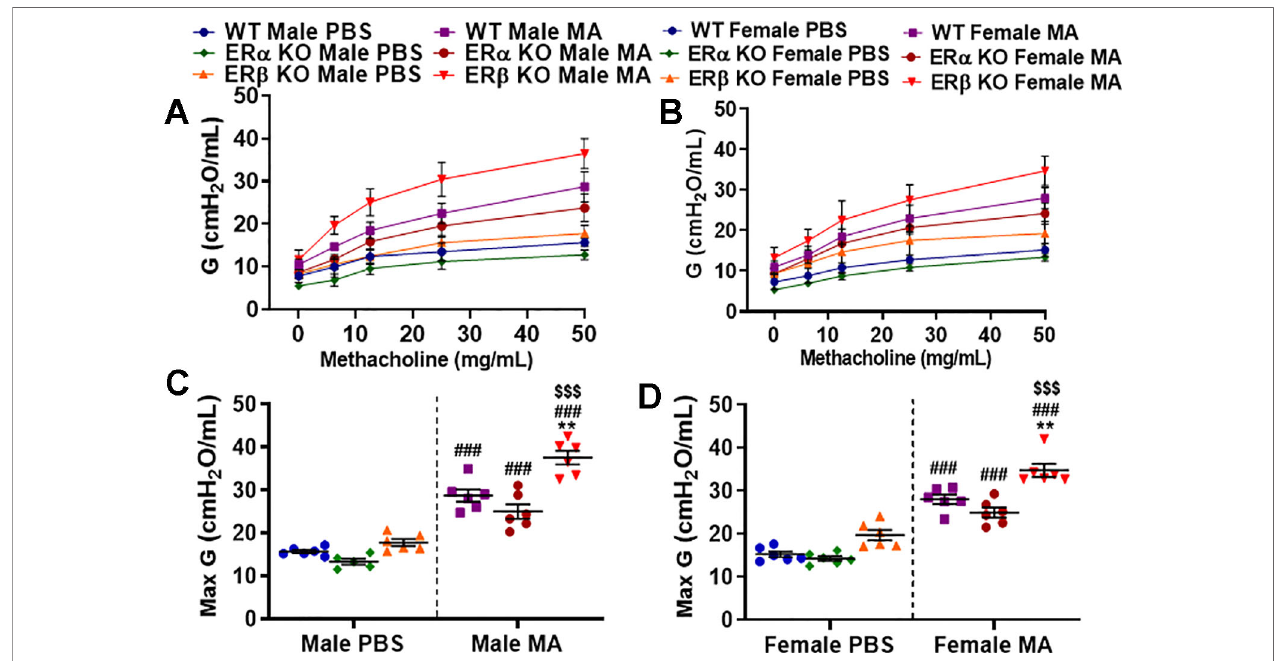
FIGURE 5 | Effect of ER signaling on tissue damping (G) in the lungs of (A) male and (B) female mice (WT vs. ER a KO vs. ER b KO) exposed to PBS and MA. Max G was used to compare WT, ER a KO and ER b KO in (C) male and (D) female mice exposed to PBS and MA. Data represented as mean ± SEM of at least 5-6 mice per treatment group; ### p < 0.001 vs. PBS of respective groups (MA effect), **p < 0.01 vs. WT of PBS/MA (ER speci fi c KO effect) and $$$ p < 0.001 vs. ER a KO of PBS/MA (ER b vs. ER a